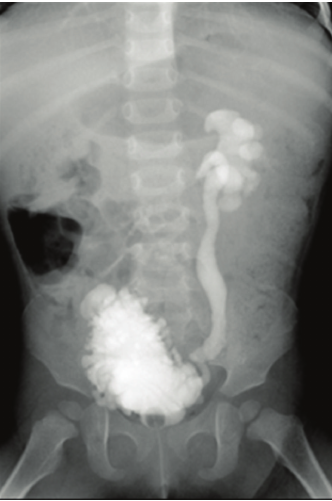
Figure 2: Cystogram showed a trabeculated bladder with fairly poor capacity and grade IV reflux.